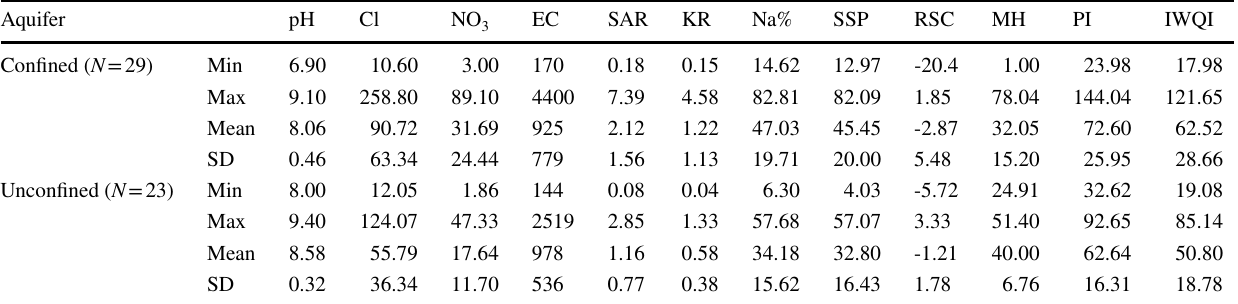
Table 9 Main descriptive statistics of parameters and IWQI method in the studied irrigation water under different aquifer types in North Kurdu- fan